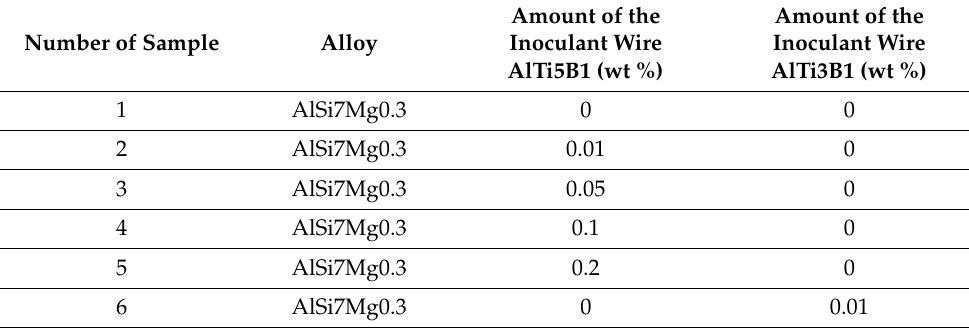
Table 1. Composition of the alloys.